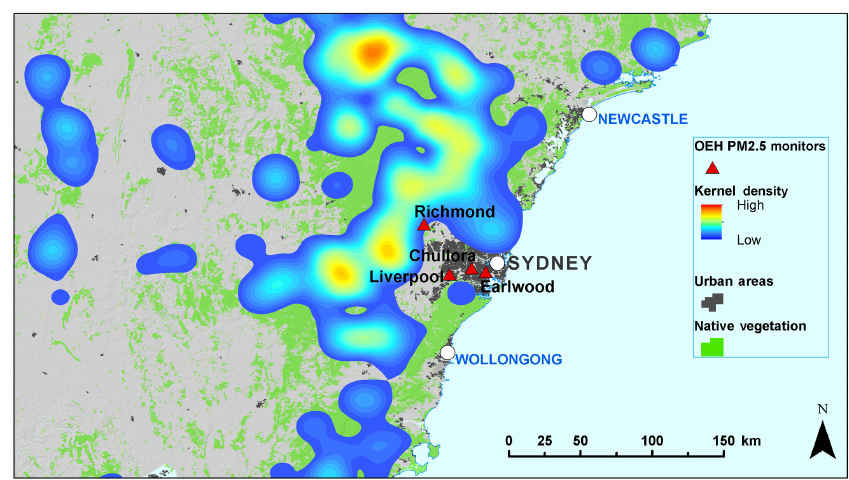
Figure 2. Kernel density function (magnitude-per-unit area) for hazard reduction burns (HRBs) conducted in the vicinity of Greater Sydney (2005–2016). The warmer the colour of the kernel density surface, the more or larger HRBs that have occurred in that area. The kernel density calculation is weighted according to fire surface